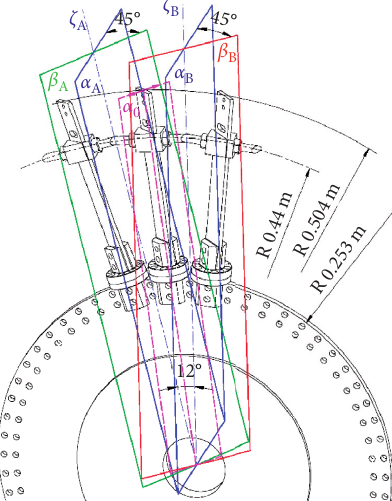
Figure 2: Scheme of the cutting planes of contact surfaces.